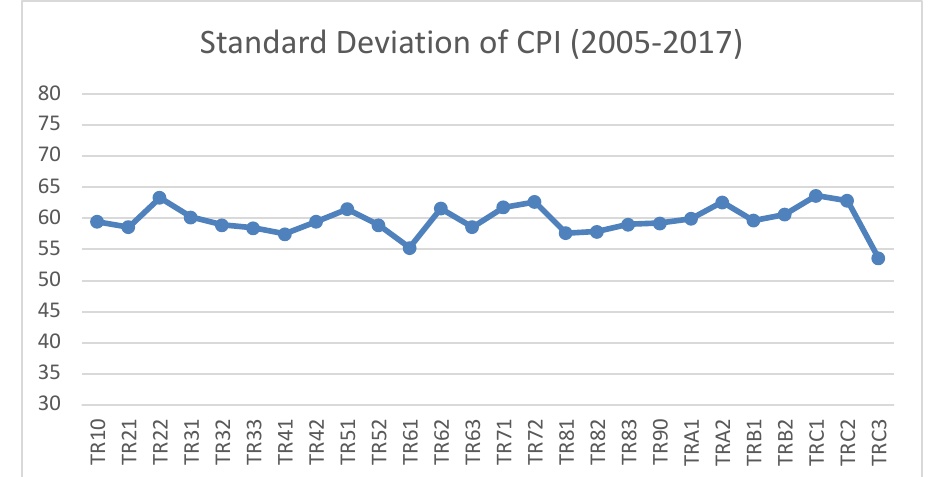
Figure 2: Standard Deviation of CPI (NUTS2) (2005-2017)